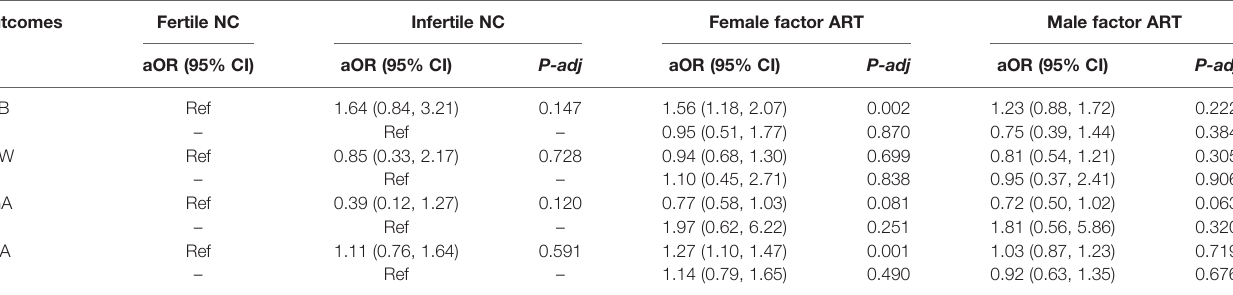
TABLE 2 | Risks of adverse perinatal outcomes in infertile groups with or without ART treatment. Outcomes Fertile